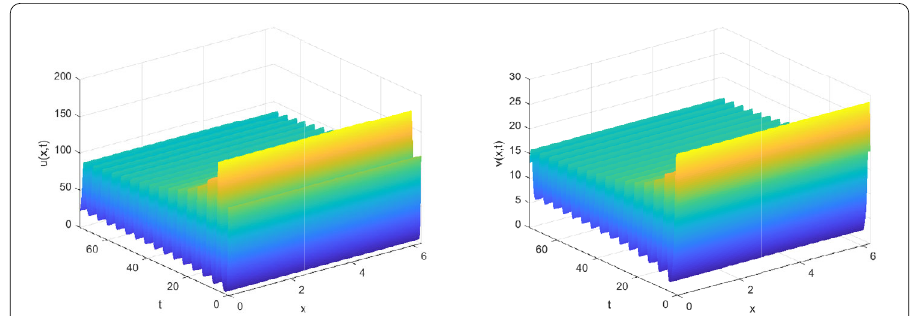
Figure 7 τ = 0.15, β = 0.06 and the initial condition is (117.47,18.78). The system produces periodic solutions